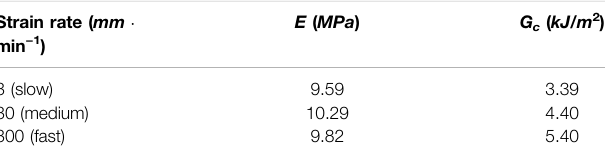
TABLE 3 | The sizes of all IOLs in axial and pro fi le views (Nanavaty and Kubrak- Kisza, 2017). The minor axis length (in bold) were selected for